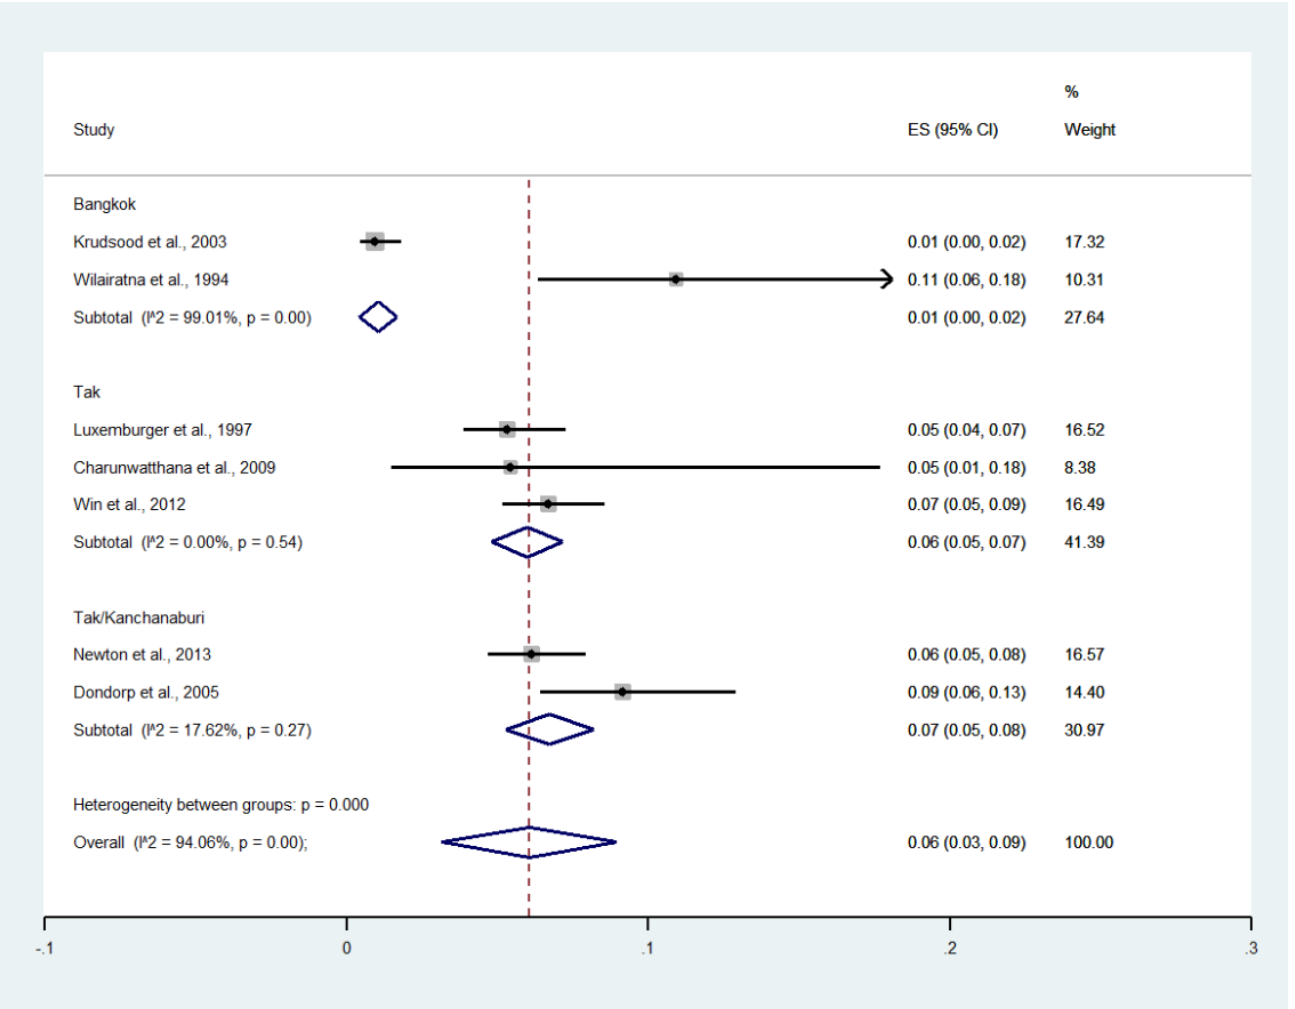
Figure 18. The pooled prevalence of deaths among patients with severe malaria in Thailand. The label for the x-axis is the scale of estimated prevalence. Abbreviations; ES, estimated proportion; CI, confidence interval .